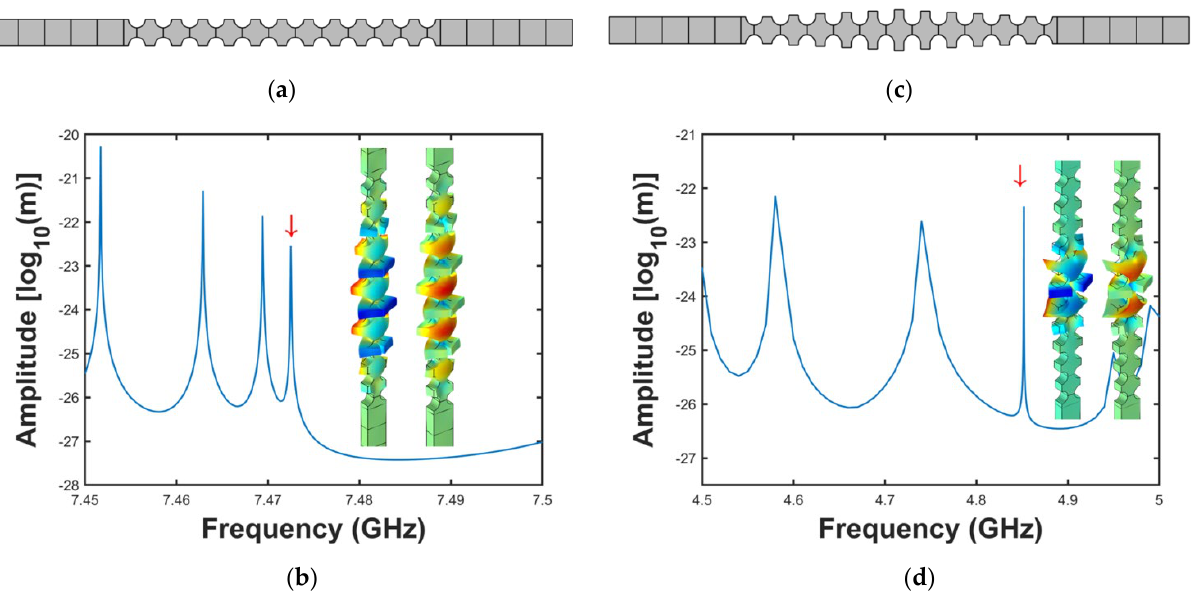
Figure 3. Sketches of the type-II fishbone and the standard fishbone (the control group): ( a ) A sketch of the standard fishbone. ( b ) The frequency spectrum of the standard fishbone. The SS mode is marked by a red arrow, and the insets are the displacement field (left) and the strain field (right). ( c ) A sketch of the type-II APW fishbone. ( d ) The frequency spectrum of the type-II fishbone. The SS mode is marked by a red arrow, and the insets are the displacement field (left) and the strain field (right).